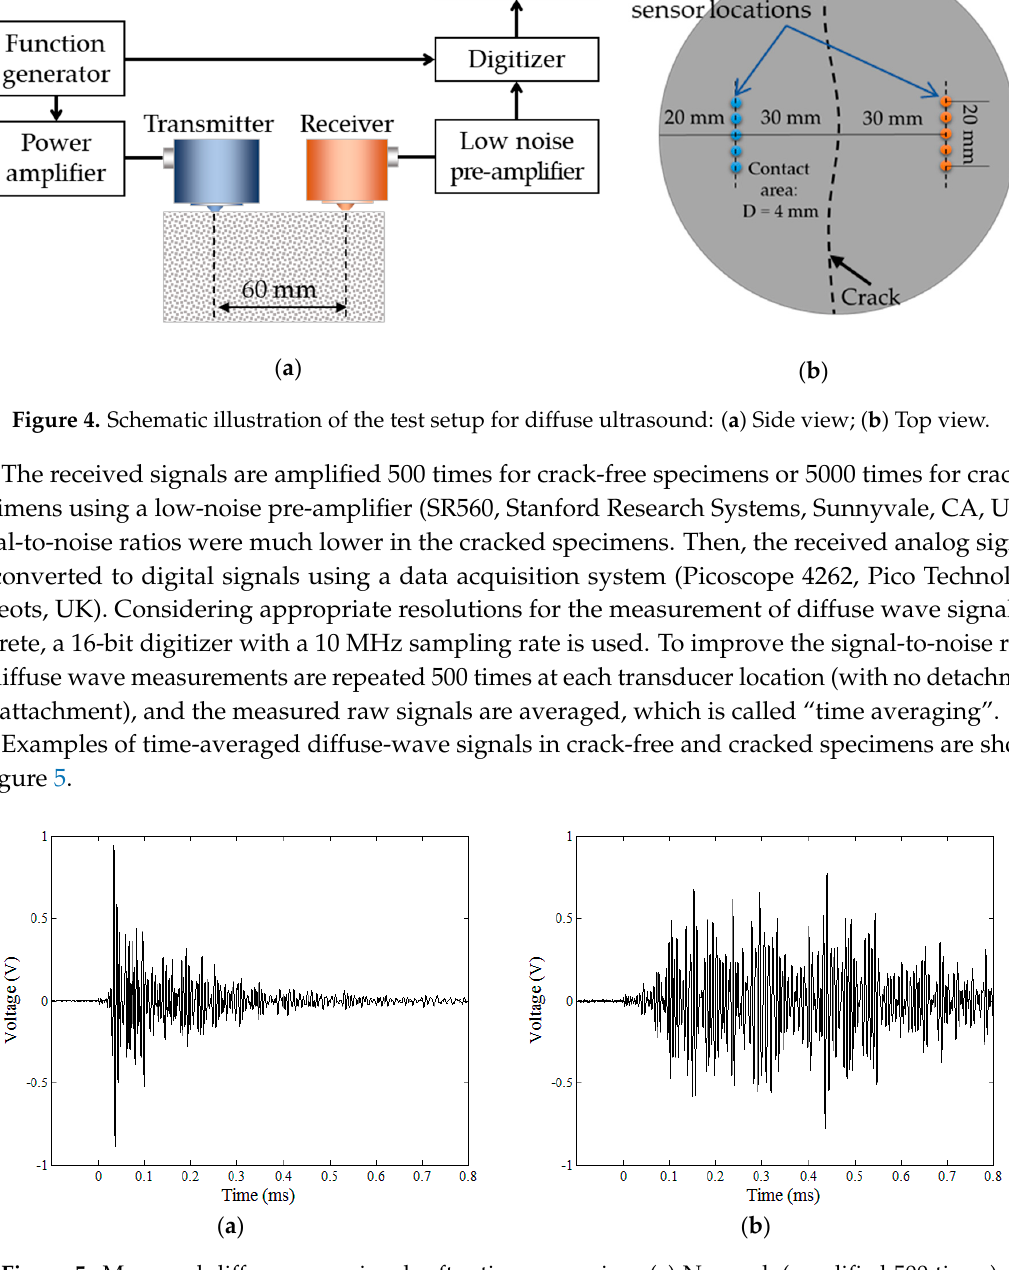
Figure 5. Measured diffuse-wave signals after time averaging: ( a ) No crack (amplified 500 times); ( b ) 0.01 mm width crack (amplified 5000 times).